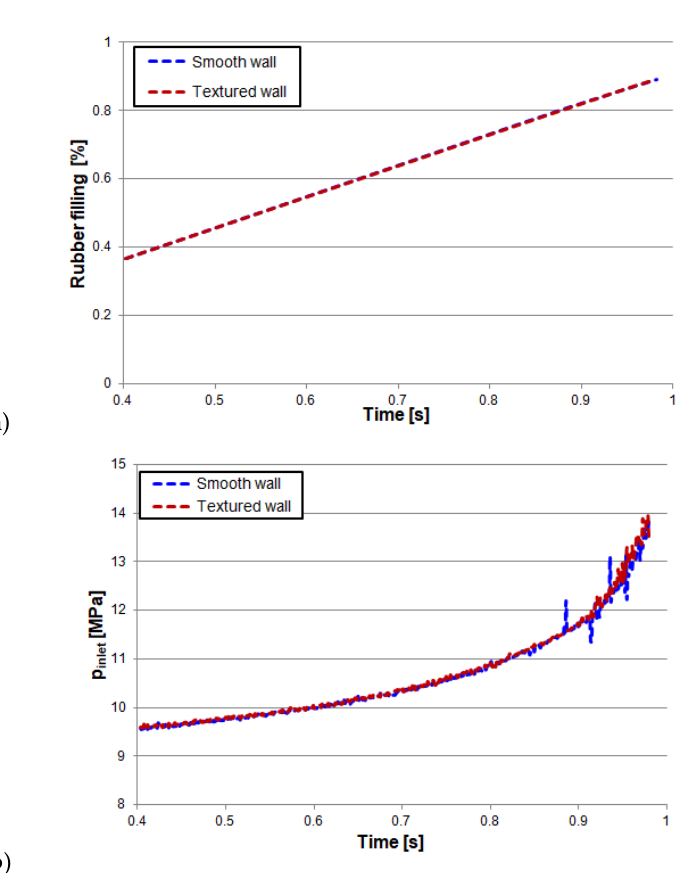
Figure 11. D-ring results:( a ) Rubber filling rate and ( b ) Inlet pressure evolution in